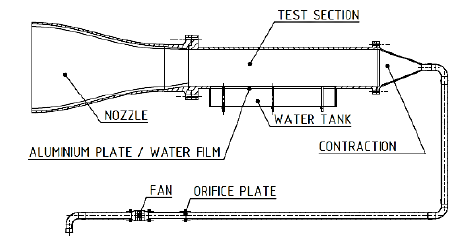
Fig. 2. Schematic of the experimental test rig